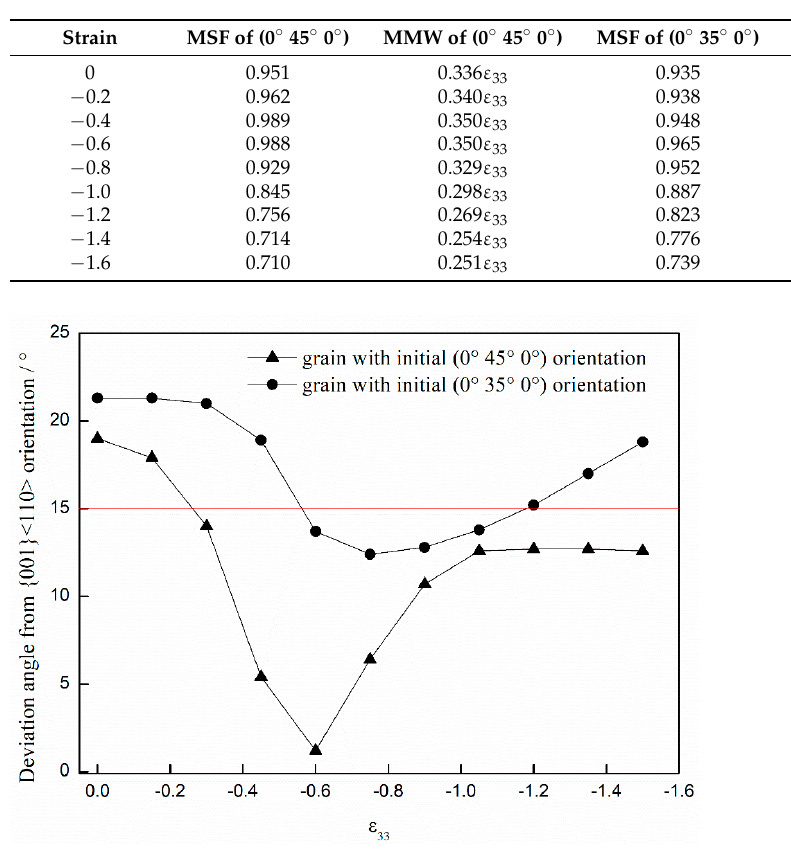
Figure 10. The effect of initial grain orientation on the deviation angle of twinning orientation from exact {001}<110> orientation during cold rolling.